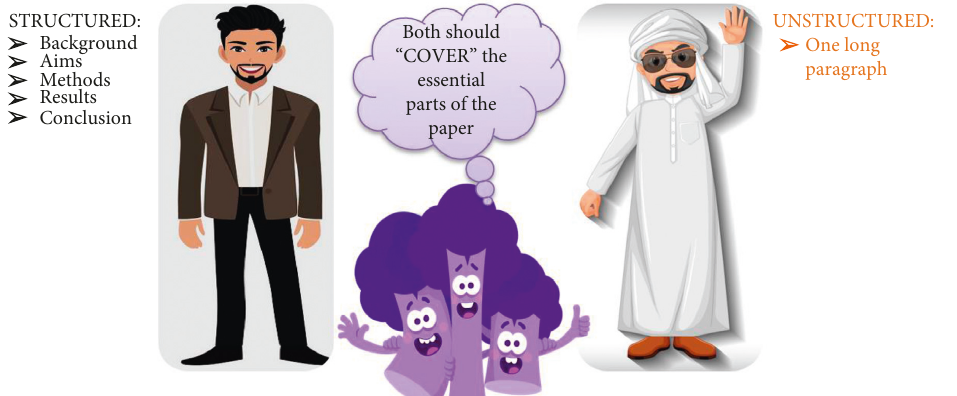
Figure 4: Two major types of abstract—structured and unstructured. Structured abstracts are piecemealed into five different things, each consisting of one or two sentences, while unstructured abstracts consist of single paragraph written about the same things.